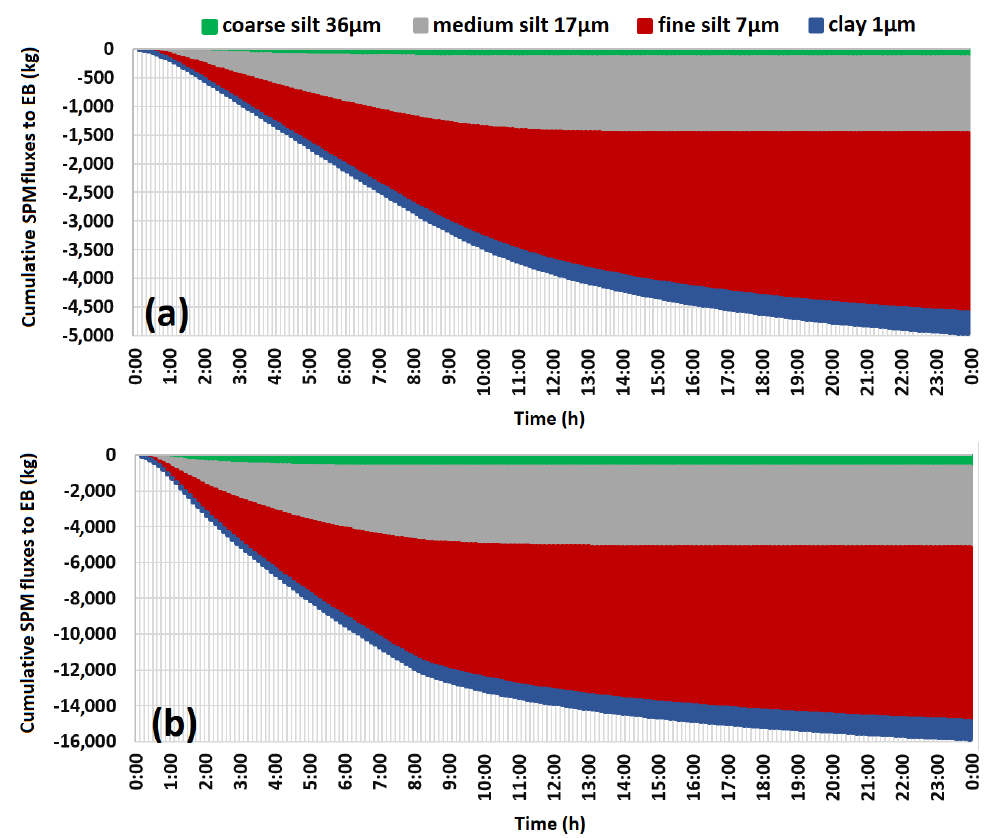
Figure 11. Cumulative flux of suspended particulate matter to EB in the present configuration ( Q 1 = 0) and for a wind speed of 15 m/s; ( a ) N-NW wind, ( b ) S-SE